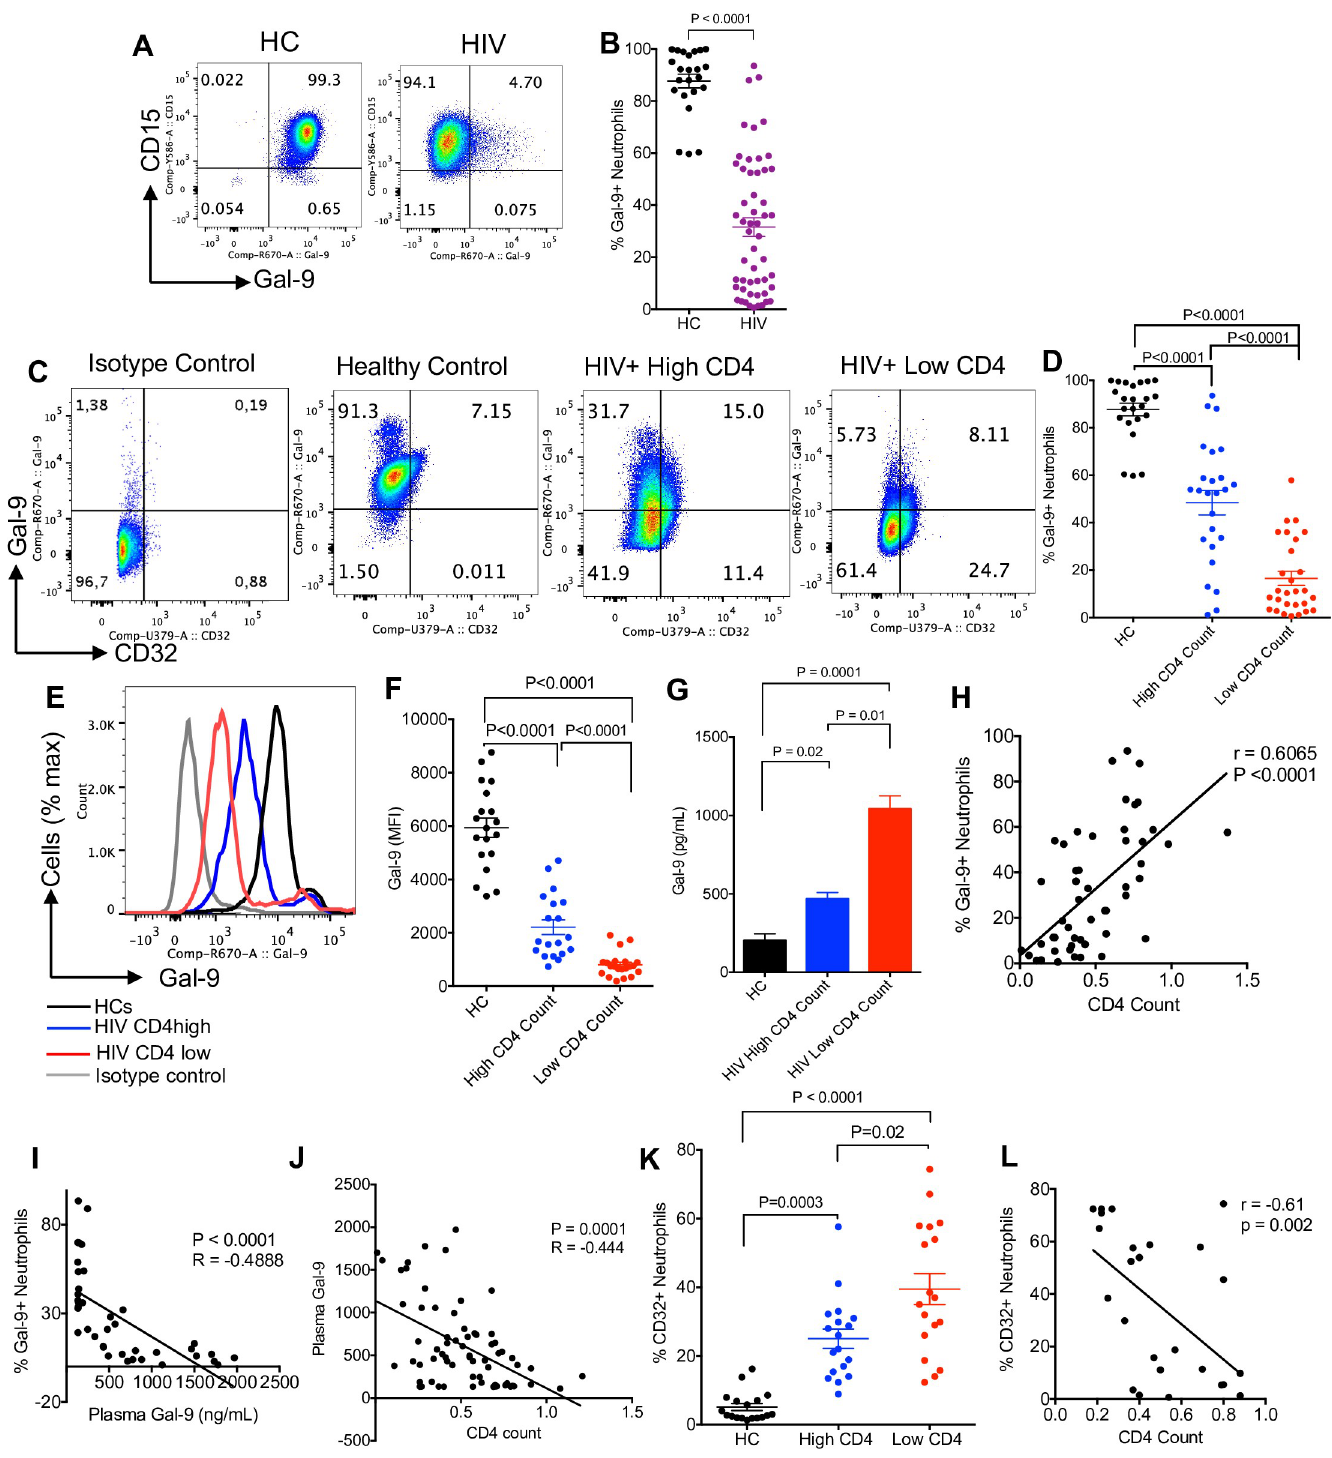
Fig 3. Neutrophils shed Gal-9 in HIV infection. (A) Representative plots and (B) cumulative data showing Gal-9 expression on neutrophils of HCs versus HIV- infected individuals. (C) Representative plots showing surface expression of Gal-9 and CD32 on neutrophils. (D) Cumulative data comparing surface expression of Gal-9 in neutrophils from HCs versus HIV patients with high and low CD4 T-cell count. (E) Representative histogram and (F) MFI of surface Gal-9 on neutrophils from HIV patients with high CD4 or low CD4 T-cell count and HCs. (G) ELISA results showing the concentration of soluble Gal-9 from unstimulated neutrophils obtained from HCs or HIV patients cultured for 8 hours. (H) Correlation between CD4 T-cell count and Gal-9+ neutrophils. (I) Correlation between Gal-9